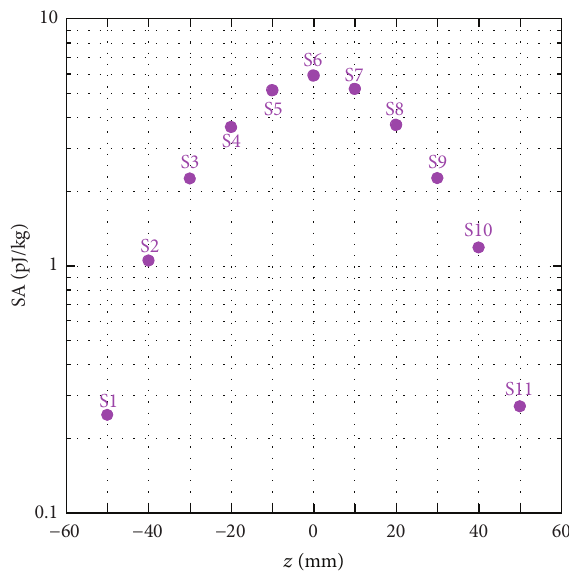
Figure 4: SA evaluated inside the skin